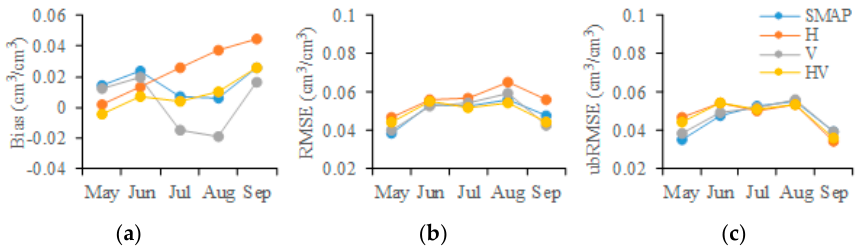
Figure 12. ( a ) Monthly bias, ( b ) RMSE and ( c ) ubRMSE of estimated SSM from the 2016-2018 SMAP descending brightness temperature based on the four algorithms (SMAP baseline, DCA-H, DCA-V and DCA-HV)